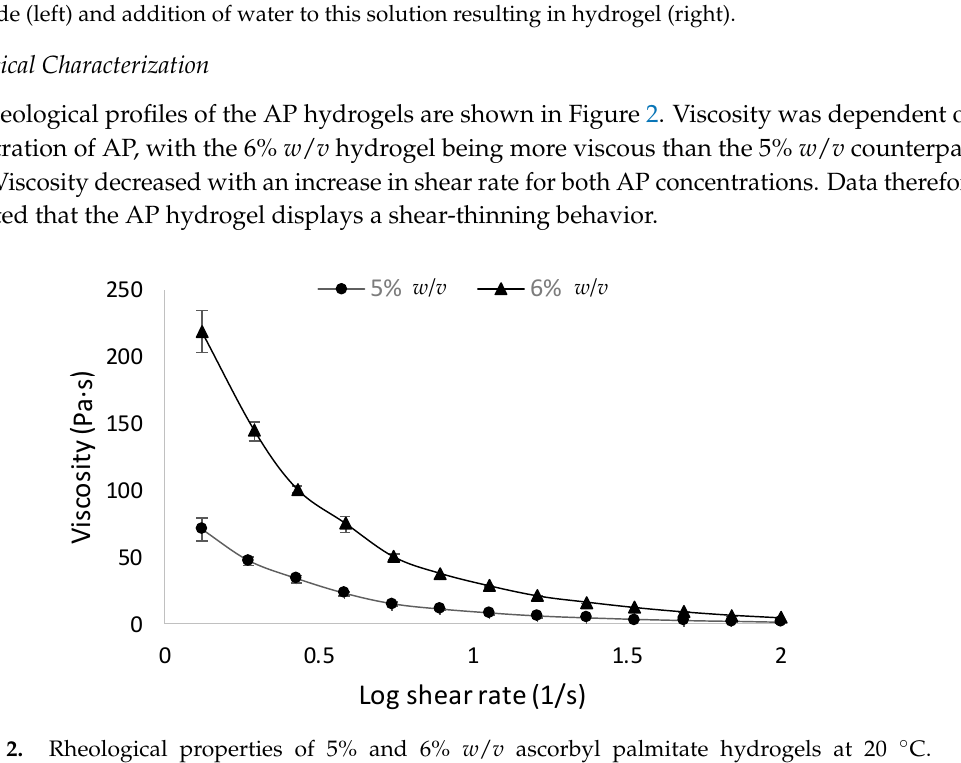
Figure 2. Rheological properties of 5% and 6% w / v ascorbyl palmitate hydrogels at 20 °C. Three independent studies per sample were performed. Data shown as means ± SD.